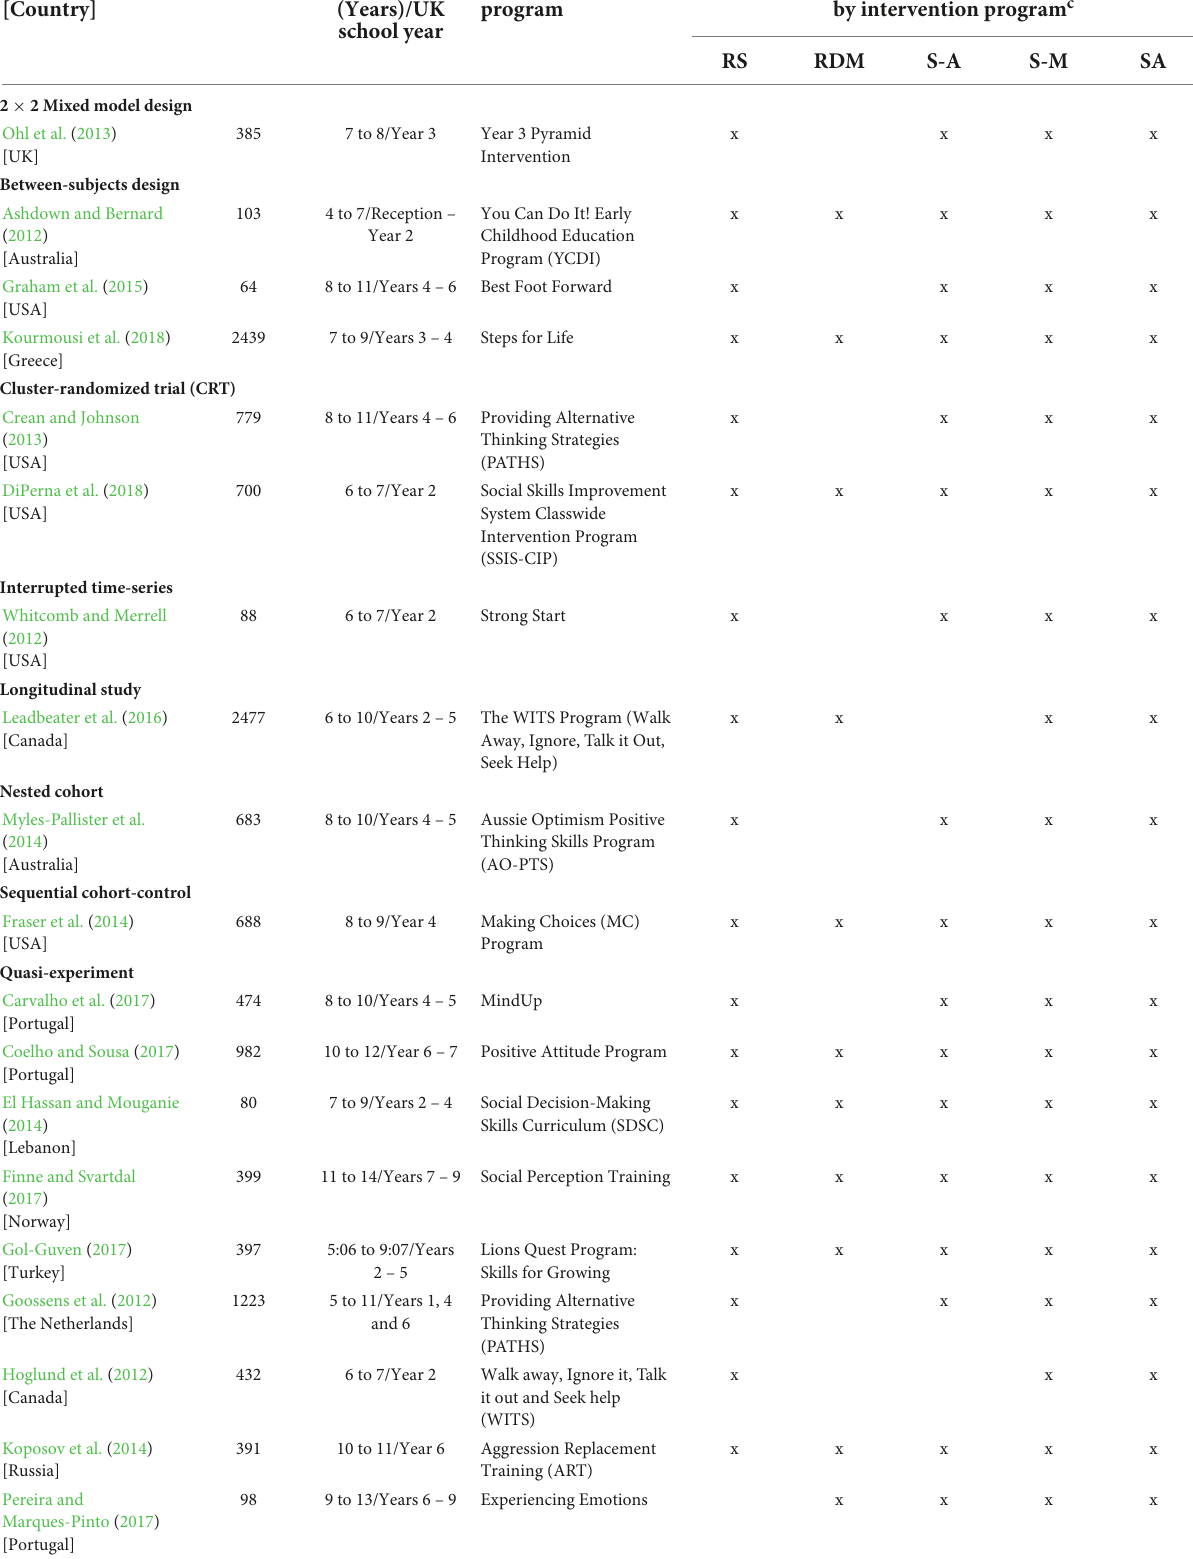
TABLE 1 Summary of interventions included in review grouped by study design including: Number of participants, child participant age band, social skills program selected for intervention, and intervention-targeted social-cognitive areas a . Study